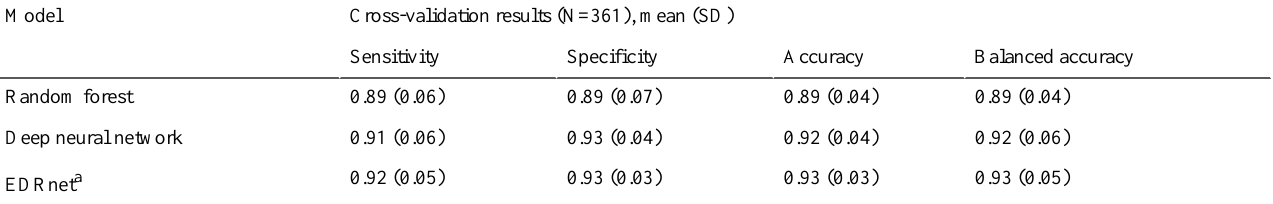
Cross-validation results (N=361), mean (SD)Model